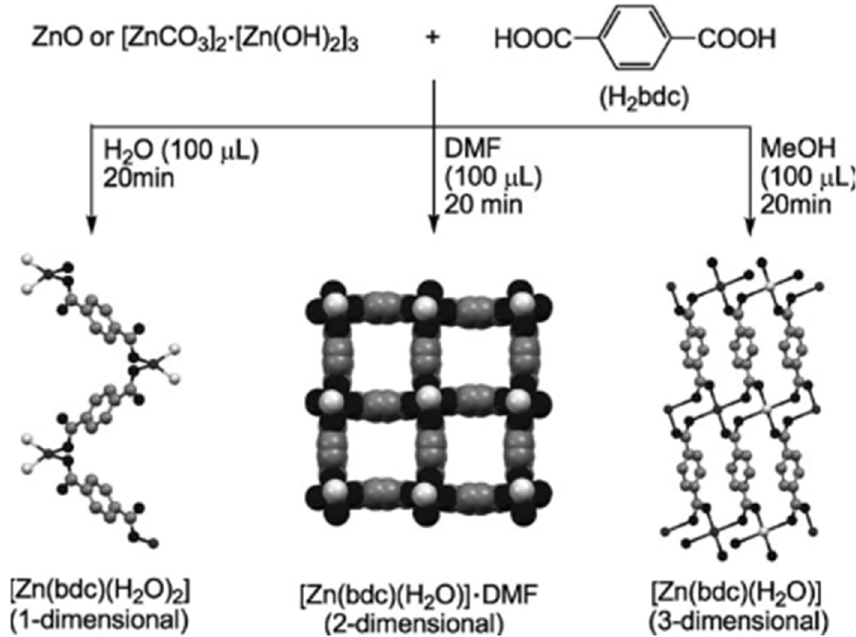
Figure 7. Synthesis of MOFs using liquid-assisted grinding (LAG) [32].Reproduced with permis- sion.